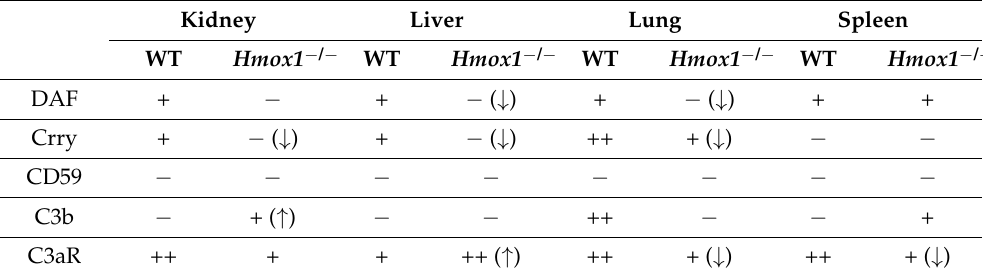
Table 1. CRP and C3aR expression in WT and Hmox1 -/- tissue samples and C3b